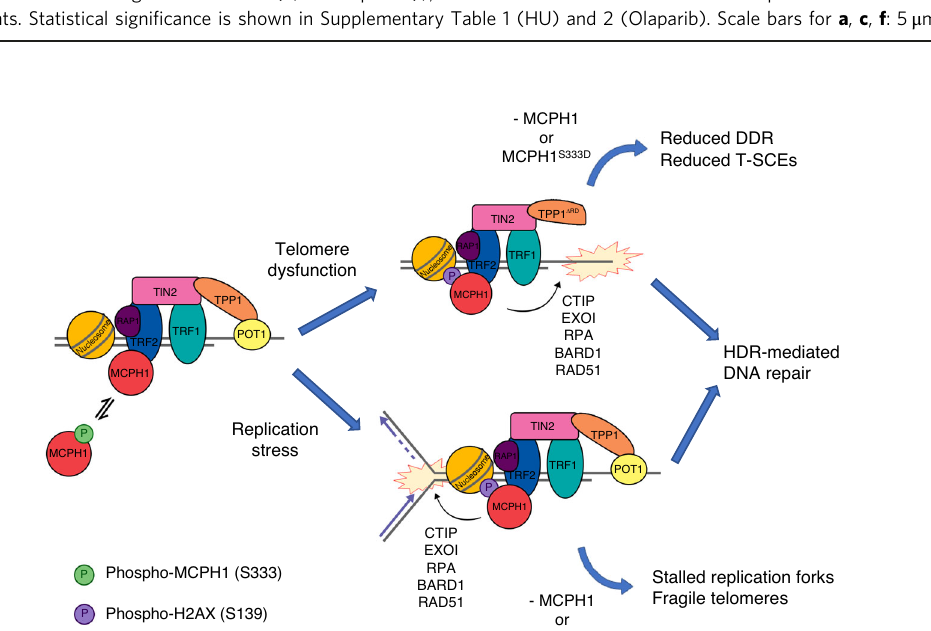
Fig. 6 MCPH1 is required for recruitment of HDR factors to stalled replication forks to promote fork restart. a MCPH1 (red) and γ -H2AX (green) immunostaining in the indicated cells lines treated with either DMSO or 0.25 μ M APH. Representative images from either three (MCPH1 + / + and MCPH1 Δ / Δ + vector cells) or two (MCPH1 Δ / Δ + WT MCPH1 cells) independent experiments. b Mean values ± SD of the percentage of cells with >5 MCPH1/ γ -H2AX co-localizations from ( a ). n = 3 for MCPH1 + / + and MCPH1 Δ / Δ + vector cells, n = 2 for MCPH1 Δ / Δ + WT MCPH1 cells. At least 200 nuclei were scored. One-way ANOVA followed by Tukey ’ s multiple comparison test. c MCPH1 (red) and SMARCAL1 (green) immunostaining in U2OS cells treated with either DMSO or 0.25 μ M APH. Representative images from three independent experiments. d Mean values± SD of the percentage of cells with >5 co-localizing MCPH1/SMARCAL1 foci from ( c ). n = 3., at least 200 cells scored. Two-sided Student ’ s t test. e Percentage of cells with >5 BARD1, RAD51 or p-RPA32 (S4/S8) foci co-localizing with γ -H2AX in the indicated cell lines treated with either DMSO or 0.25 μ M APH. Representative images are shown in Supplementary Fig. 8a. Data represent mean values± SD, n = 2. At least 200 nuclei were examined. One-way ANOVA followed by Tukey ’ s multiple comparison test. f Representative images from two independent time course experiments to assess γ -H2AX foci (green) resolution in the indicated cell lines after release of HU block. Cells were incubated with 2 mM HU for 24 h before replacing the media and then fi xed at the indicated time points. Untreated cells were used as control. g Number of γ -H2AX foci observed in 50 – 100 cells from each sample shown in ( f ). Data from one representative experiment. Red line: median. Kruskal – Wallis test followed by Dunn ’ s multiple comparison test. h , i Cell viability assay of MCPH1 + / + and MCPH1 Δ / Δ cells treated with increasing amount of HU ( h ) or Olaparib ( i ), with or without concomitant BRCA1 depletion. Data from one of three independent experiments. Statistical signi fi cance is shown in Supplementary Table 1 (HU) and 2 (Olaparib). Scale bars for a , c , f : 5 μ m.